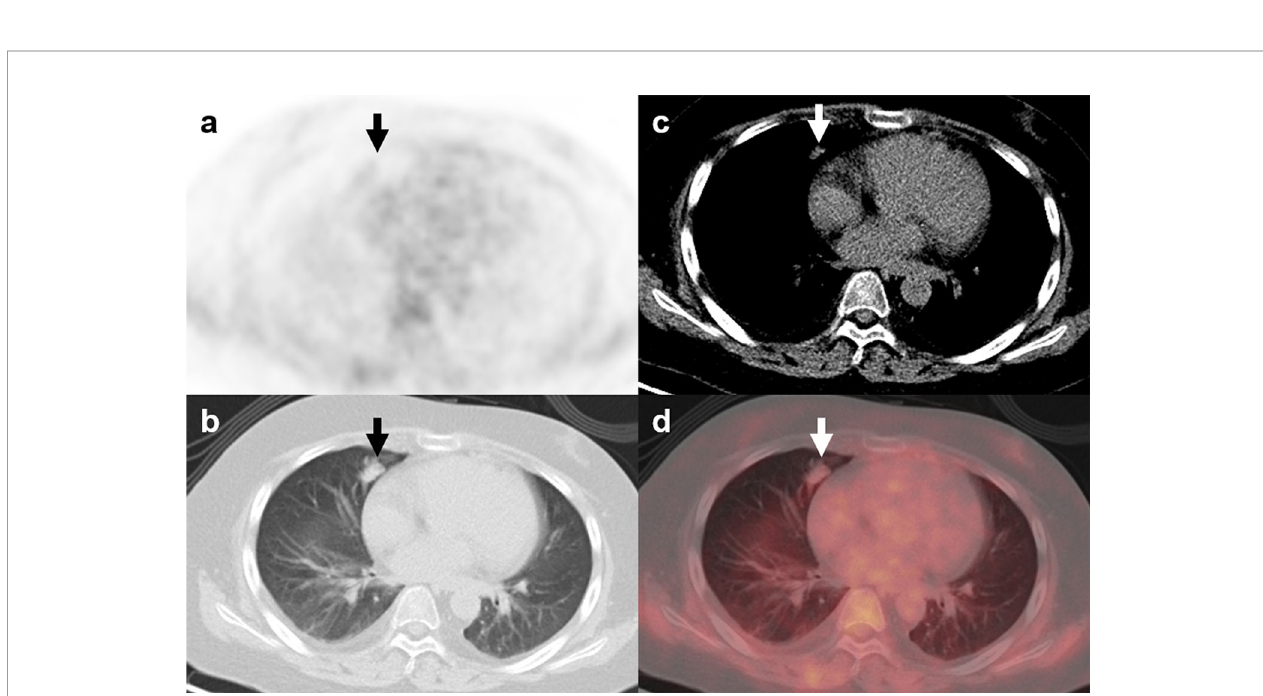
FIGURE 6 | 18 F-FDG PET/CT fi ndings in a representative case of atypical carcinoid (Patient, 21). A 16-year-old man was diagnosed with ectopic Cushing syndrome. The patient underwent 18 F-FDG PET/CT to localize the source of ACTH secretion. PET/CT images revealed a nodule with mild FDG activity ( A – D ; arrows; SUV max , 1.1) in the right lung. The lesion was surgically removed, and histopathological analysis con fi rmed the diagnosis of atypical carcinoid with ACTH positivity in